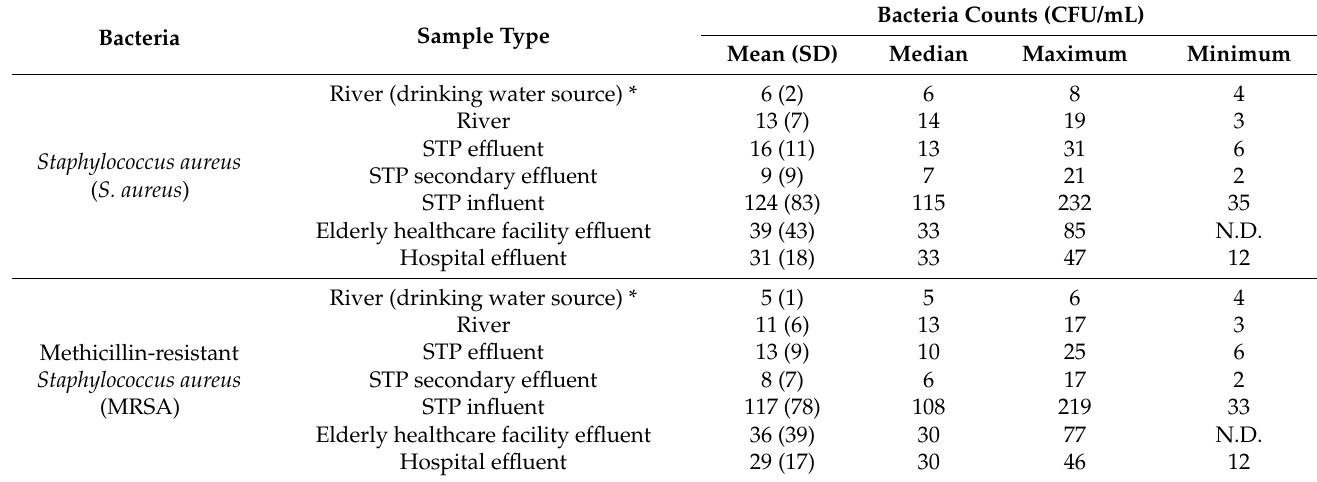
Table 1. Occurrence of Staphylococcus aureus ( S. aureus ) and methicillin-resistant Staphylococcus aureus (MRSA) in hospital effluent, elderly healthcare facility effluent, sewage treatment plant (STP) influent, STP secondary effluent, STP effluent, and river water (*: The river water as a drinking water source was supplied to the study area and neighboring regions, N.D.: Not